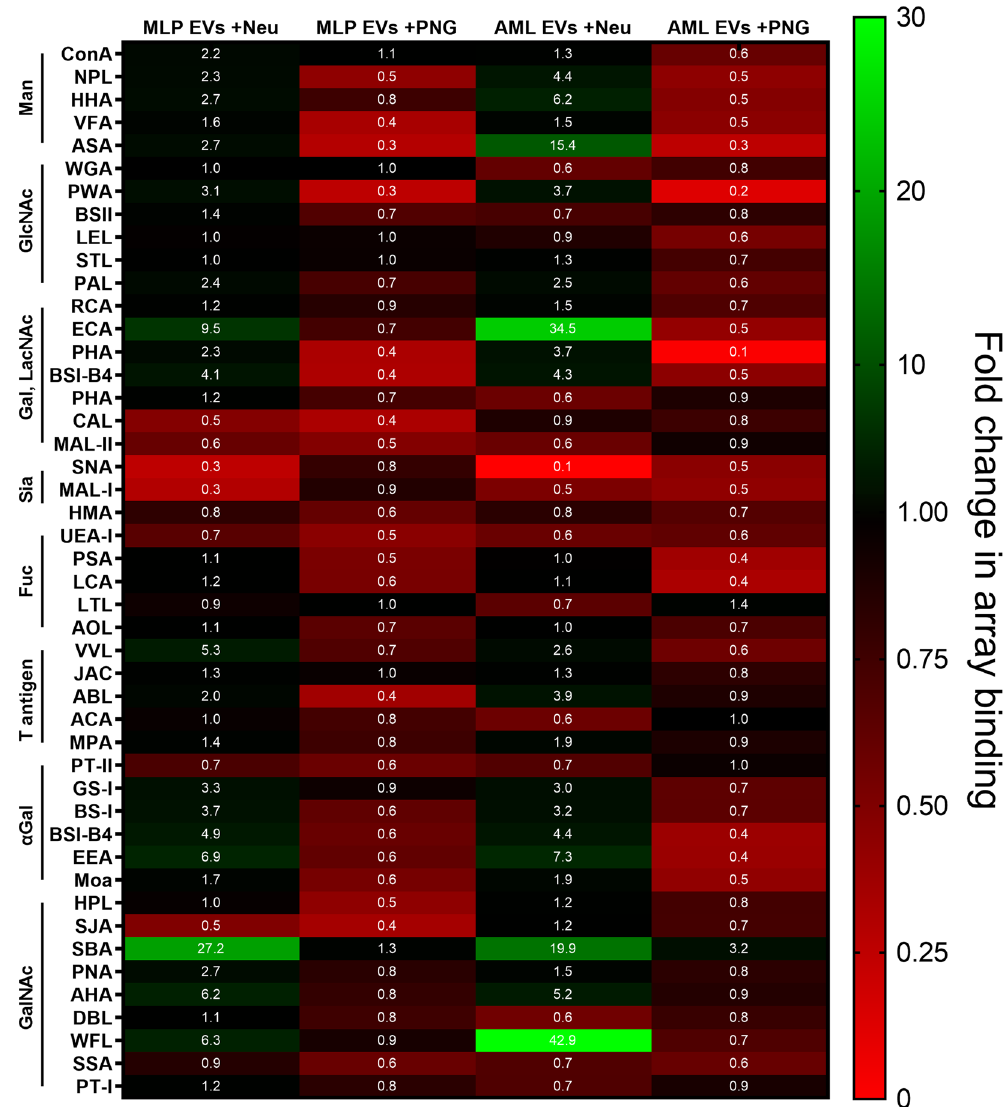
Figure 2. Heat map visualisation for lectin array analysis of EVs after neuraminidase (Neu) or Peptide-N- Glycosidase F (PNG) treatments. The normalised data represent the fold change in fluorescence signal from array binding, relative to EVs of native